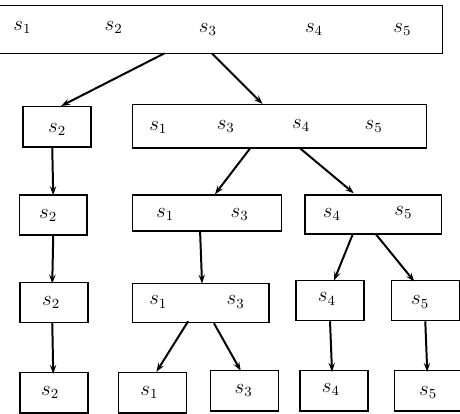
Figure 1. The hierarchical quotient space structure (HQSS) of R .